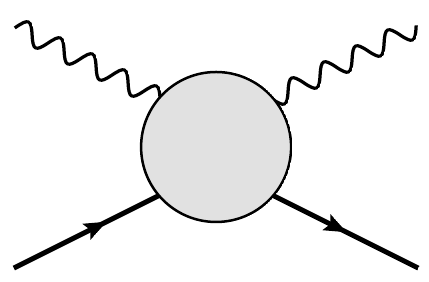
Figure 1 . The gravitational Compton scattering with two massive spin particles and two